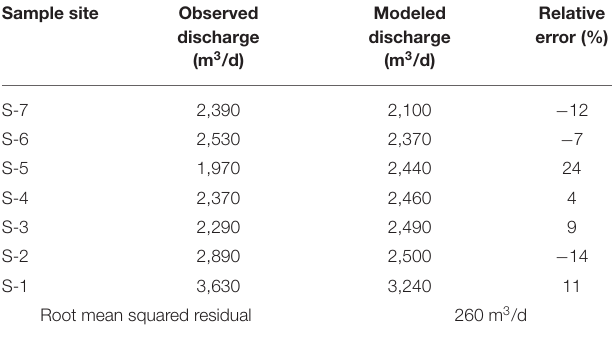
TABLE 3 | Observed and modeled groundwater head levels of the calibrated MODFLOW model with relative error. Observation point